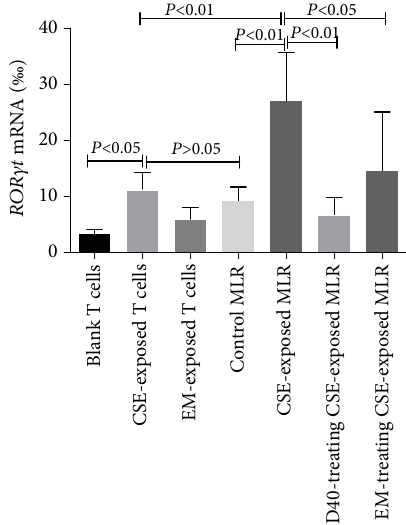
Figure 3: E ff ects of CSE and EM on the DC-induced expression of ROR γ t mRNA in the MLR. ROR γ t mRNA levels were evaluated by quantitative RT-PCR ( n = 6 ). (The height of the bar chart represents the mean and the height of the error line indicates the standard errors of the means in the histogram.)